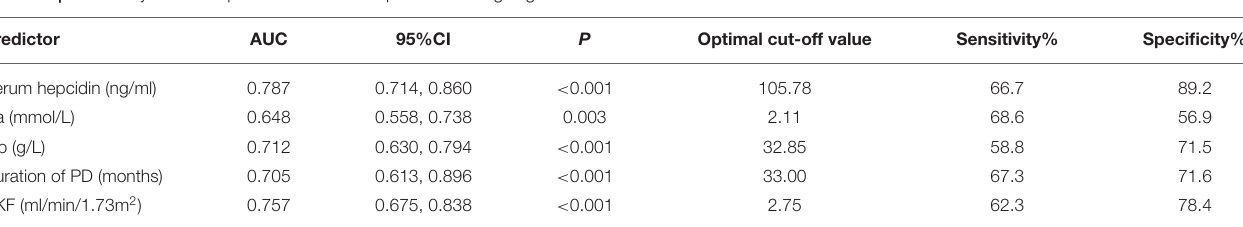
TABLE 3 | ROC analyses of five predictors for RLS in patients undergoing PD.